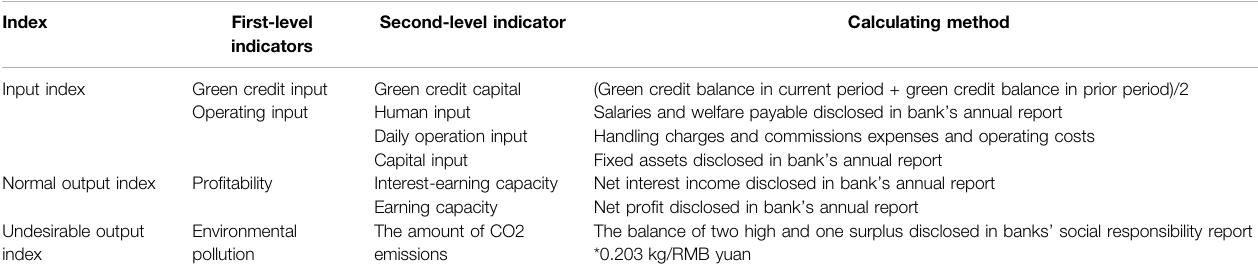
TABLE 2 | Green credit ef fi ciency index of commercial bank in